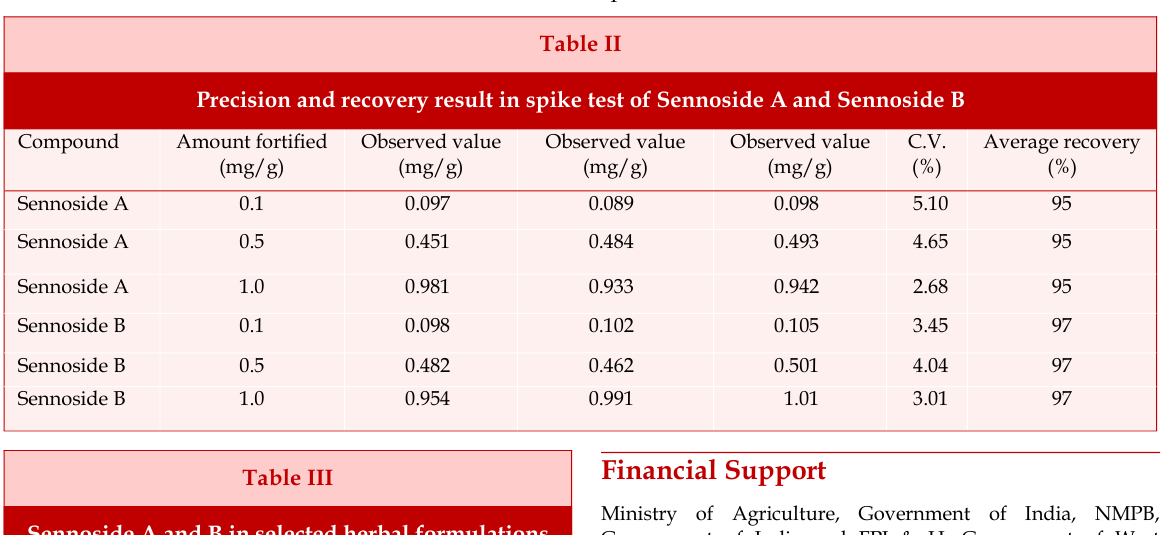
Sennoside A and B in selected herbal formulations Herbal formu-